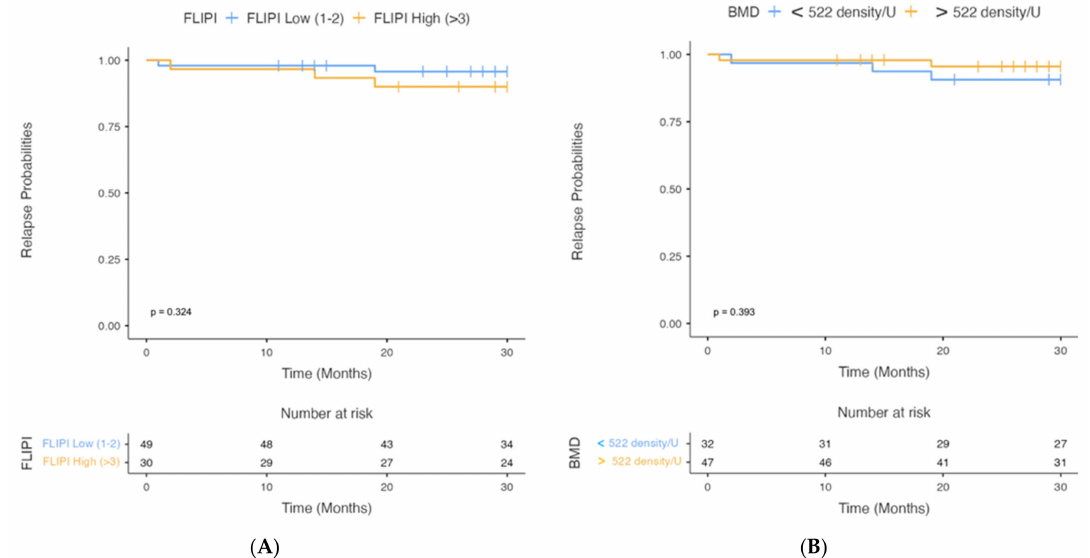
Figure 5. Analysis of PFS according to FLIPI Score ( A ) and BMD Cut-off ( B